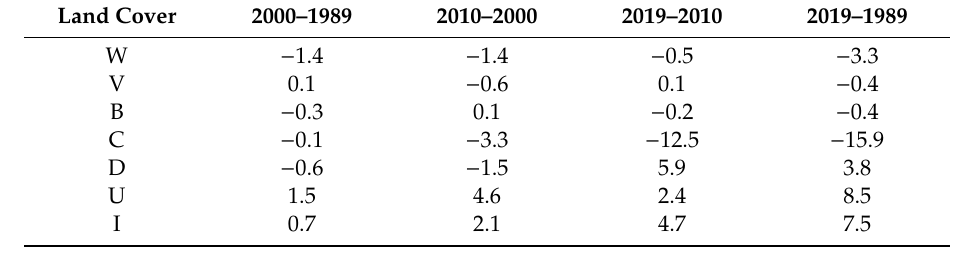
Table 5. LULC changes (as percentages) in the study area between 1989 and 2019.